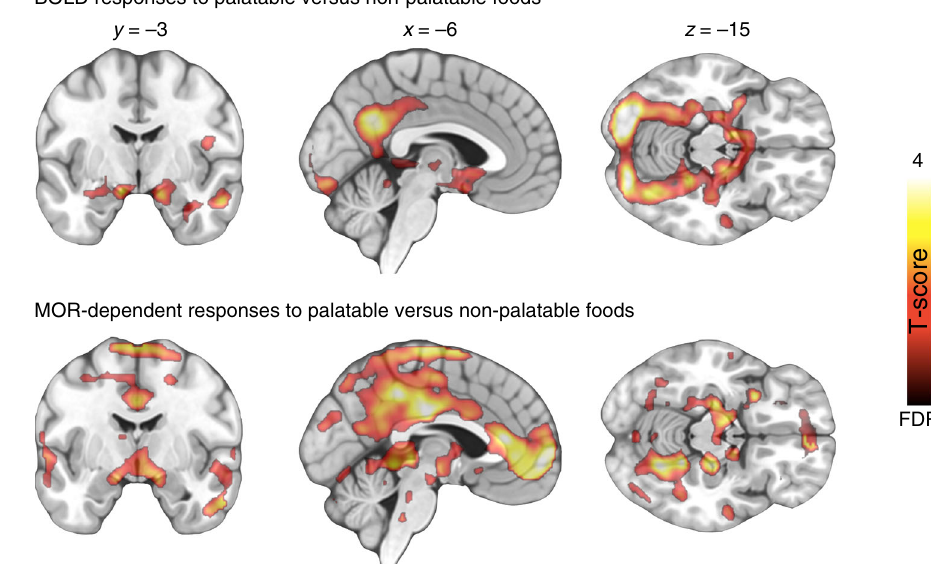
Fig. 4 BOLD responses to food pictures. Top row: Brain regions where BOLD-fMRI responses were larger when viewing palatable versus non-palatable foods ( n = 33). Bottom row: brain regions where MOR availability in thalamus were negatively associated with BOLD-fMRI responses when viewing palatable versus non-palatable foods ( p < 0.05, FDR corrected at cluster level). Colourbar shows the T statistic range 2 r = –0.63 r = –0.57